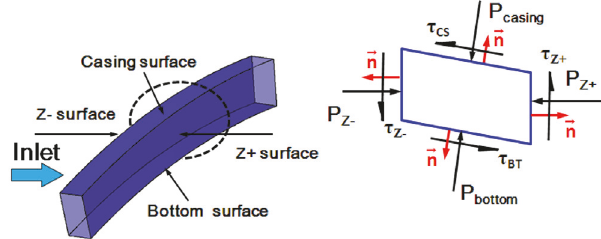
Figure 13: The volumetric illustration of typical control volumes ([16]). Figure reproduced from NAN et al.